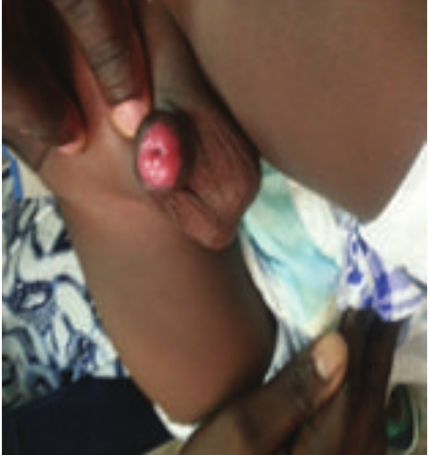
Figure 7: Glans at eight weeks following surgery.